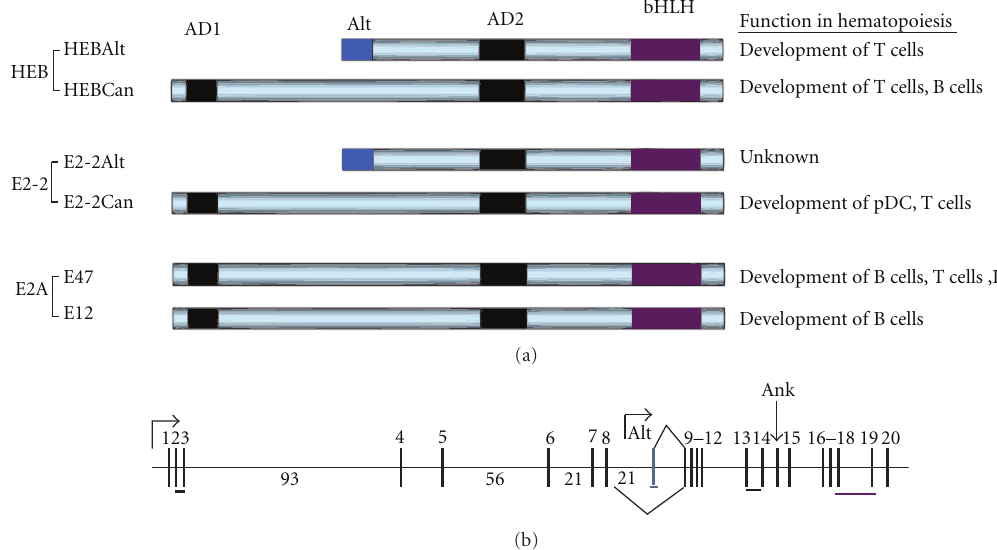
Figure 3: Structure of E-proteins. (a) E-proteins belong to the basic helix-loop-helix (bHLH) family of transcription factors. There are three genes, each encoding for two proteins: HEB (HEBCan and HEBAlt), E2-2 (E2-2Can and E2-2Alt), and E2A (E47 and E12). While E2A proteins are produced by alternative splicing, HEB and E2-2 factors are generated by independent transcription start sites and alternative splicing. All six transcription factors have a basic helix-loop-helix (bHLH) domain, which enables transcription factor dimerization and binding to the DNA. Activation domains 1 (AD1) and AD2 help recruit coactivators to the transcriptional complex. The Alt domain replaces AD1 found in the canonical forms of E-proteins and is conserved between mouse HEBAlt and E2-2Alt as well as through vertebrate evolution. (b) Organization of HEB gene. Vertical grey bars represent exons. Protein domains encoded by exons are shown as horizontal bars. Numbers above exons represent exon numbers, while numbers between exons indicate genomic distance in kb. pDC: plasmacytoid dendritic cells, LMPPs: lymphoid primed multipotent